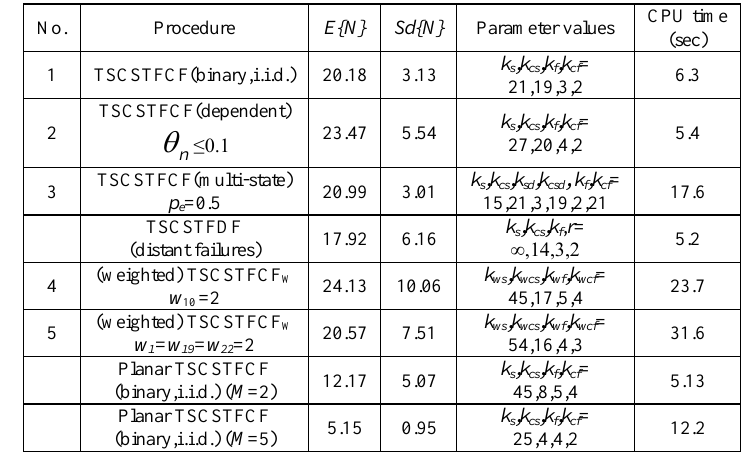
Table 8.Optimal values of the expected number of tests for different